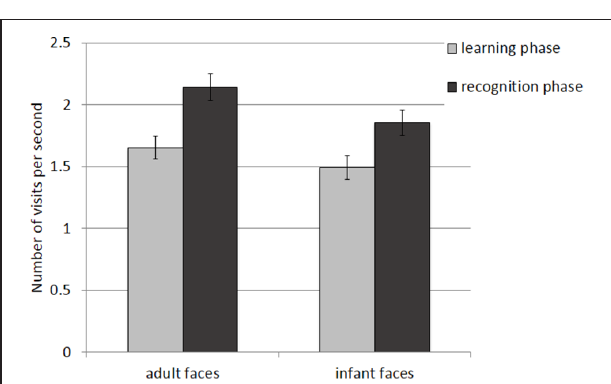
FIGURE 6 | Number of visits per second recorded on correct trials during the learning and recognition phase. Error bars represent the standard error of the